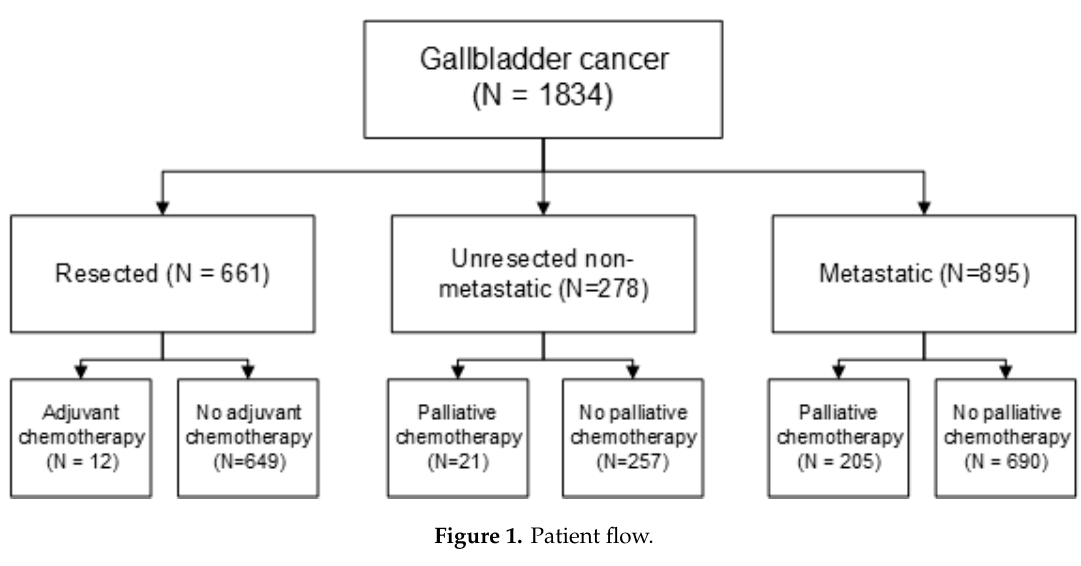
Figure 1. Patient flow. Table 1. Characteristics of patients with gallbladder cancer in the Netherlands (2005–2016).